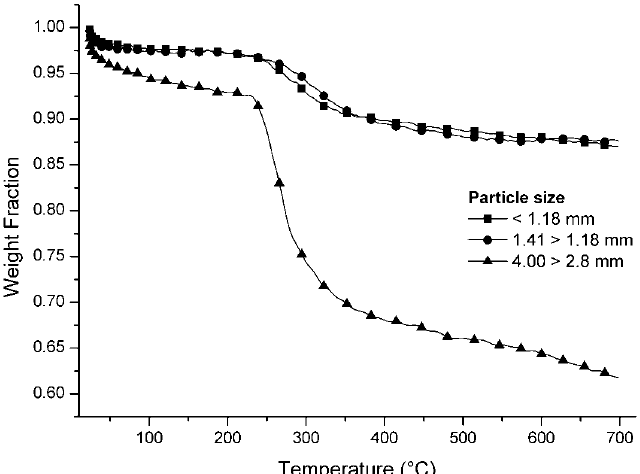
Figure 2. Thermogravimetric analysis of ground PCBs separated by particle size.